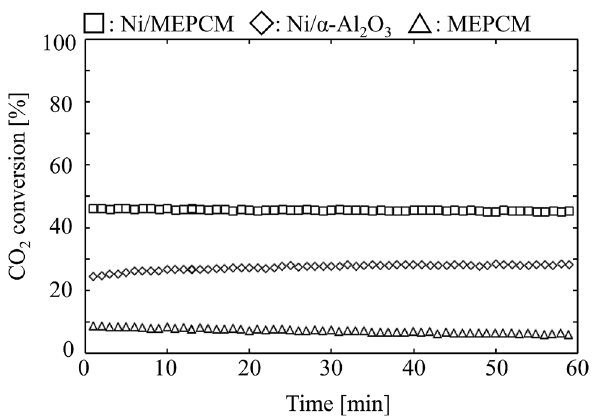
Figure 8. CO 2 conversion of the Ni/MEPCM, Ni/α-Al 2 O 3 , and MEPCM. Reaction condition: F in , CO 2 = 10 ml min −1 , F in , H 2 = 40 ml min −1 , F in , Ar = 110 ml min −1 , Reaction temperature: 400